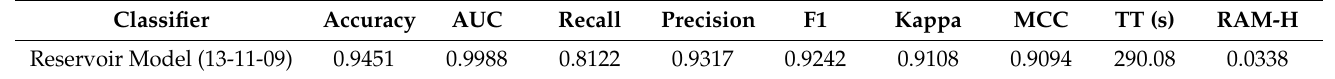
Table 5. Classification performance metrics of the reservoir